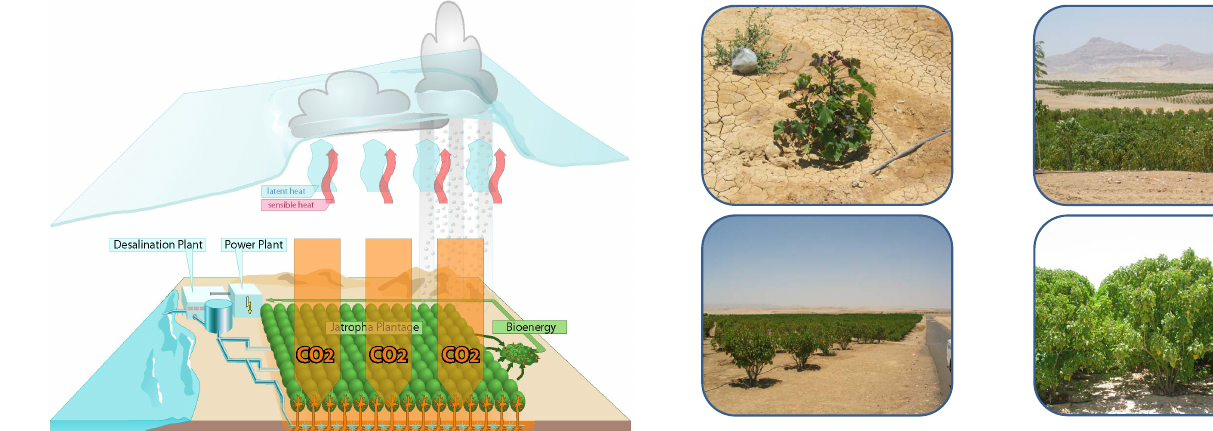
Fig.1 Outline of the carbon farming project. The top of the atmospheric boundary layer (ABL) is indicated by the blue hyper surface. 2 Fig. 1. Outline of the carbon farming project. The top of the atmo- spheric boundary layer is indicated by the blue hyper surface.